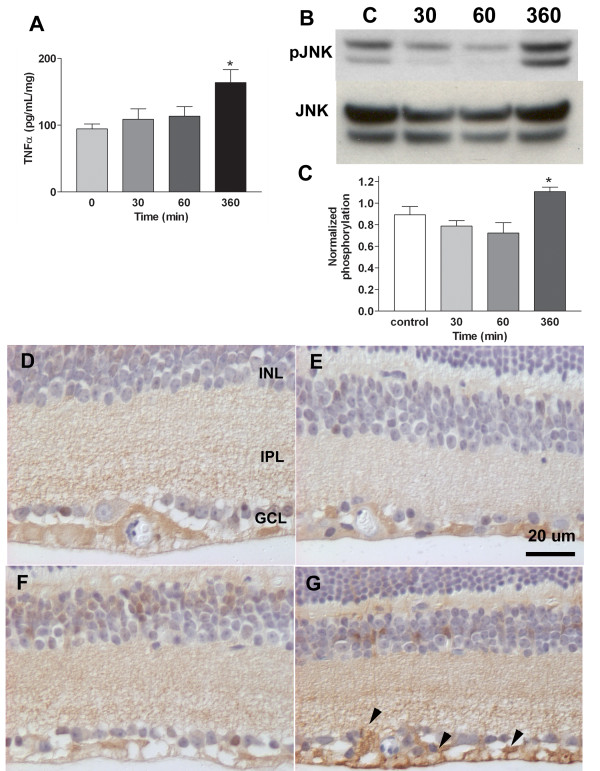
Activation of TNFα pathways. A. Detection of TNFα by ELISA in the neural retina. Cytokine levels were determined in three samples at each time point. The level at 6 hr was significantly higher. B-C. Detection of phosphorylated JNK in the neural retina. B. Western blots (upper image) were probed with an anti pJNK antibody. C. ELISA confirmed the change in activation of JNK at 6 hrs after optic nerve injury. Data are normalized to total protein. D-G. Immunohistochemistry of activated JNK in the neural retina. Antibodies to pJNK were used on sections at 0, 30 min, 60 min and 6 hr after optic nerve crush. Increased labeling is evident in the GCL (arrows) at 6 hr.